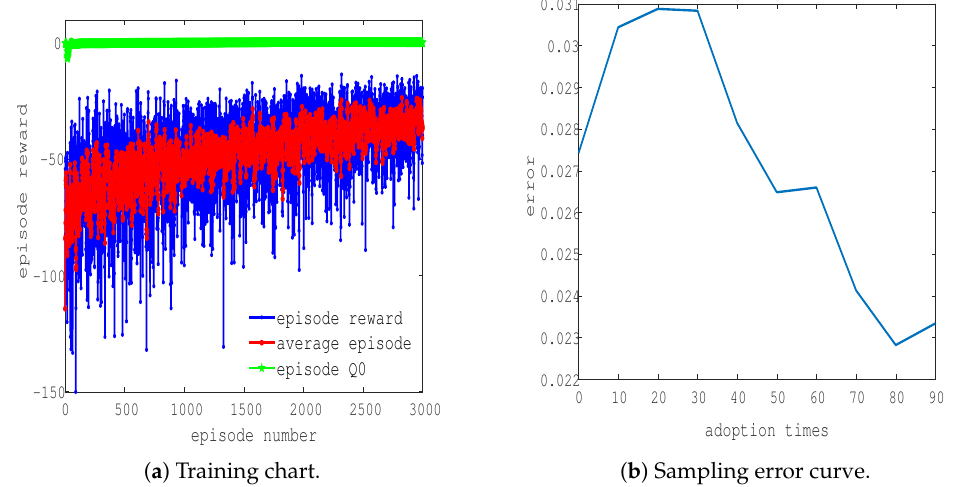
Figure 14. The second group of simulations.